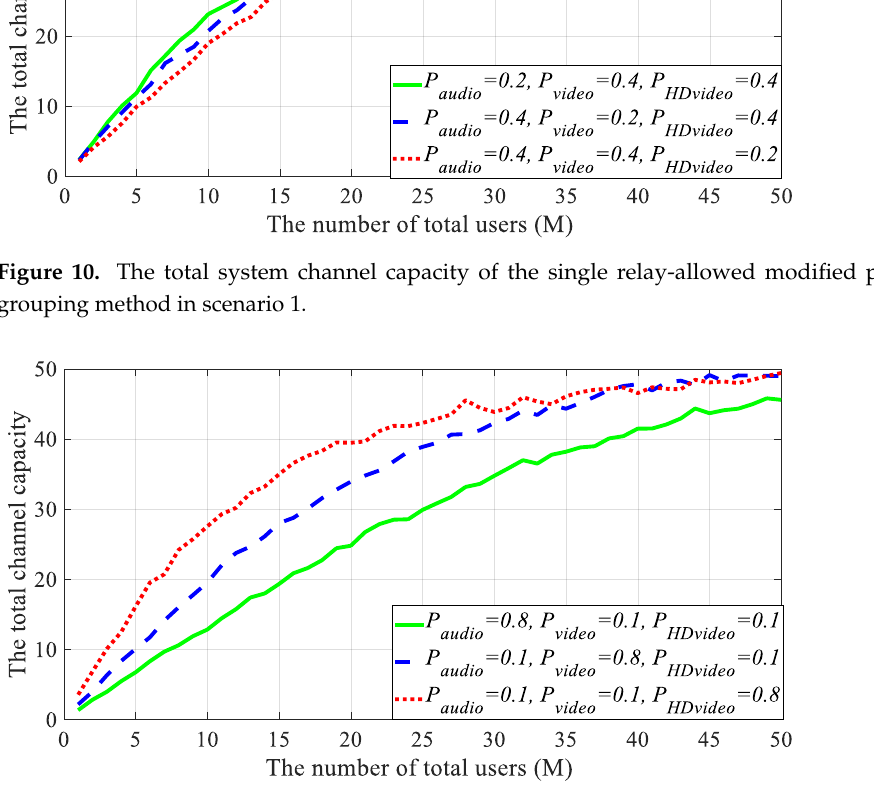
Figure 12. The total system channel capacity of the single relay-allowed modified pilot-based group- ing method in scenario 3. 4. Conclusions The grouping methods can provide strategies for relay-based cooperative networks to get better channel capacity. In this paper, the modified pilot-based grouping method is proposed to get better total system capacity. The single relay strategy with the modified grouping method also improves the channel capacity and grouping success rate. In addi- tion, because MBMS requires different amounts of content channels to attract users, we also analyzed different grouping scenarios for multi-services. The proposed grouping methods can provide for the satellite-terrestrial communication system to implement the STC technique to increase the grouping success probability. The strategy analysis for multi-services can also be used to implement in MBMS. Going forward, the proposed grouping method can also be applied in other relay- based cooperative networks, such as Wi-Fi system, ad hoc sensor networks, and IoT net- works. Finally, even though our proposed grouping methods can increase the total chan- nel capacity, the mobility issue is worth studying further. For a moving user, the best two relays will be changed, and an error might occur for STC decoding. In the future work, there might be another grouping strategy for moving users. Author Contributions: J.-S.L., J.-H.W., C.-H.C., and C.-E.W. contributed equally to the literature review of pilot-based grouping method, then developed the first discussions about the different parameters of the proposed methodology and conducted the simulations and analysis of results. C.- E.W. guided the investigation and supervised this work. J.-S.L. gave suggestions and guidance for the research. All authors have read and agreed to the published version of the manuscript.